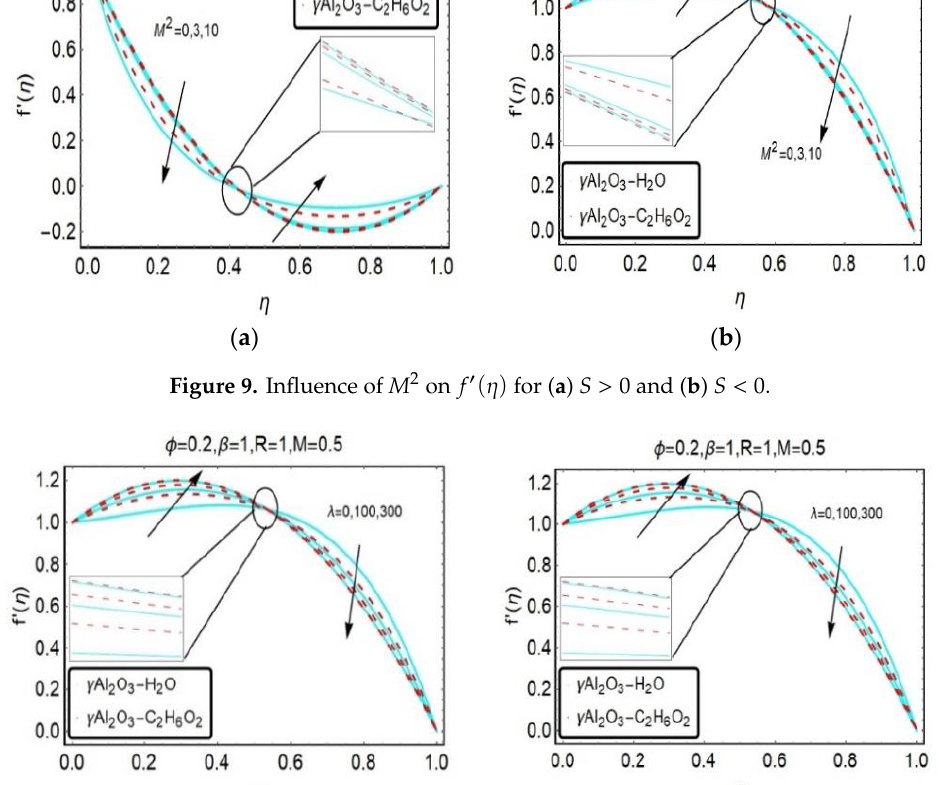
Figure 10. Influence of 𝜆 on 𝑓′(𝜂) for (a) 𝑆 > 0 and (b) 𝑆 < 0.